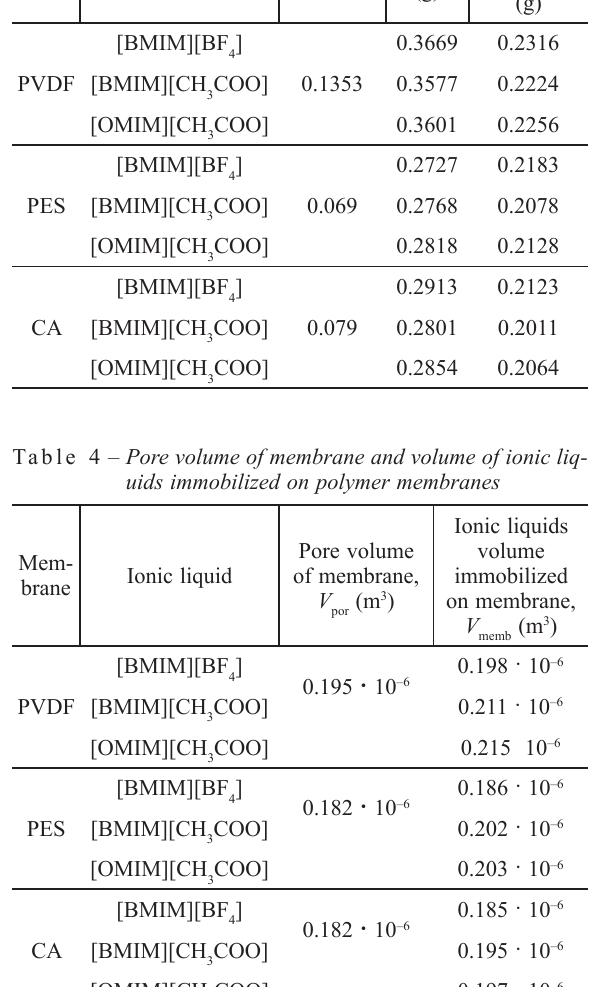
Table 3 – Determination of ionic liquids weight immobilized on polymer membranes Weight Original of Mem- Ionic liquid membrane brane c: [OMIM][CH 3 COO])